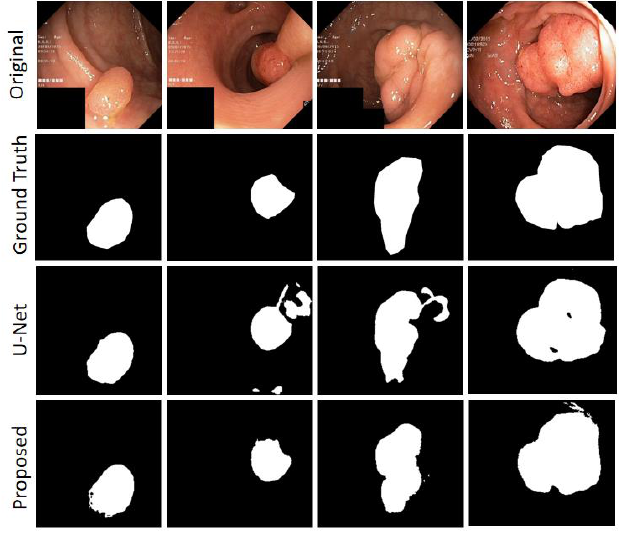
Figure 10. Kvasir-SEG Segmentation output sample.